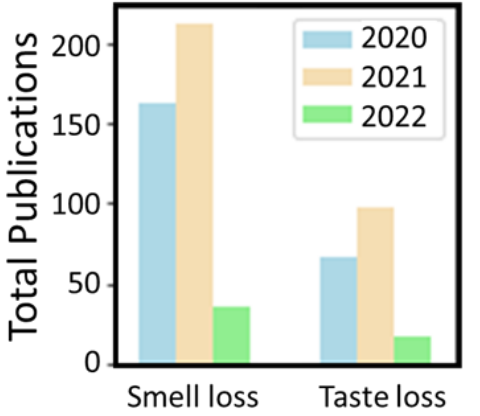
Figure 1. Comparison of total publications on either smell or taste loss and COVID-19 infection since the pandemic began. Data generated by searching the Web of Science using the terms “COVID taste OR COVID gustatory NOT smell NOT olfactory” and “COVID smell OR COVID olfactory NOT taste NOT gustatory” in the title field.